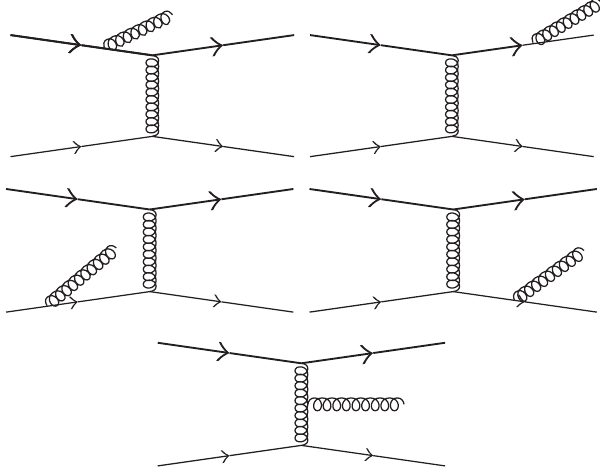
Figure 3: Feynman diagrams for gluon radiation from a single quark-quark ( 𝑞𝑞 󸀠 )